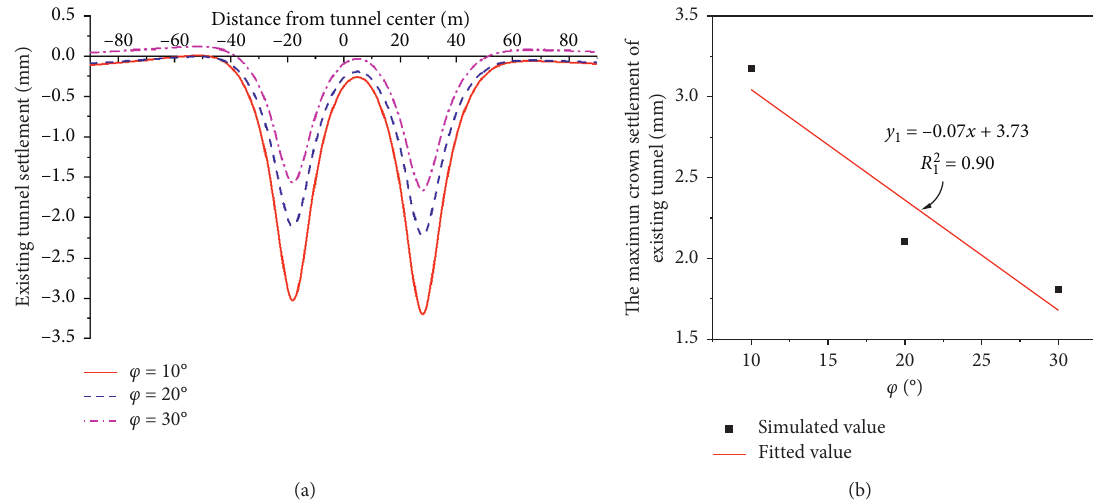
Figure 17: The influence of frictional angel on the inner deformation of existing tunnel. (a) The settlement curves of the existing tunnel. (b) The linear fitting of the maximum settlement value of the existing